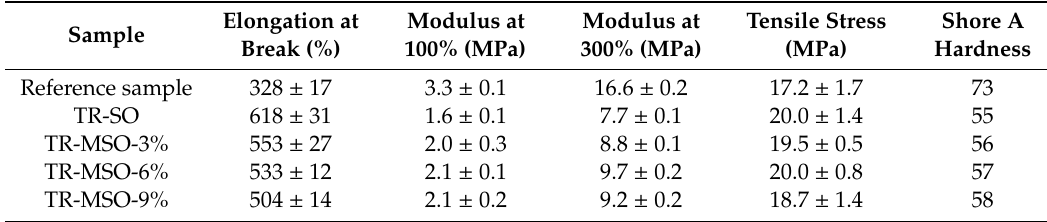
Figure 4. Stress-strain curves of tread rubber with different plasticizers. Table 4. Mechanical properties of tread rubber with di ff erent plasticizers. Table 4. Mechanical properties of tread rubber with different plasticizers.